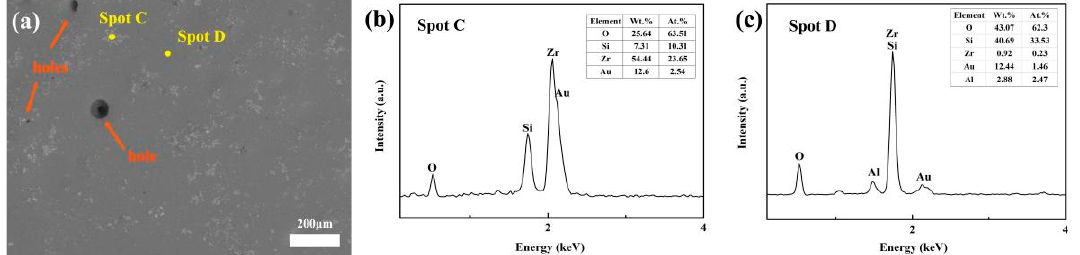
Figure 9. The backscattered electron image and EDS results of the surface of the ZrSi 2 -SiC coating containing 30 wt.% ZrSi 2 after oxidation at 1500 °C for 198 h. ( a ) SEM image; ( b , c ) EDS results.